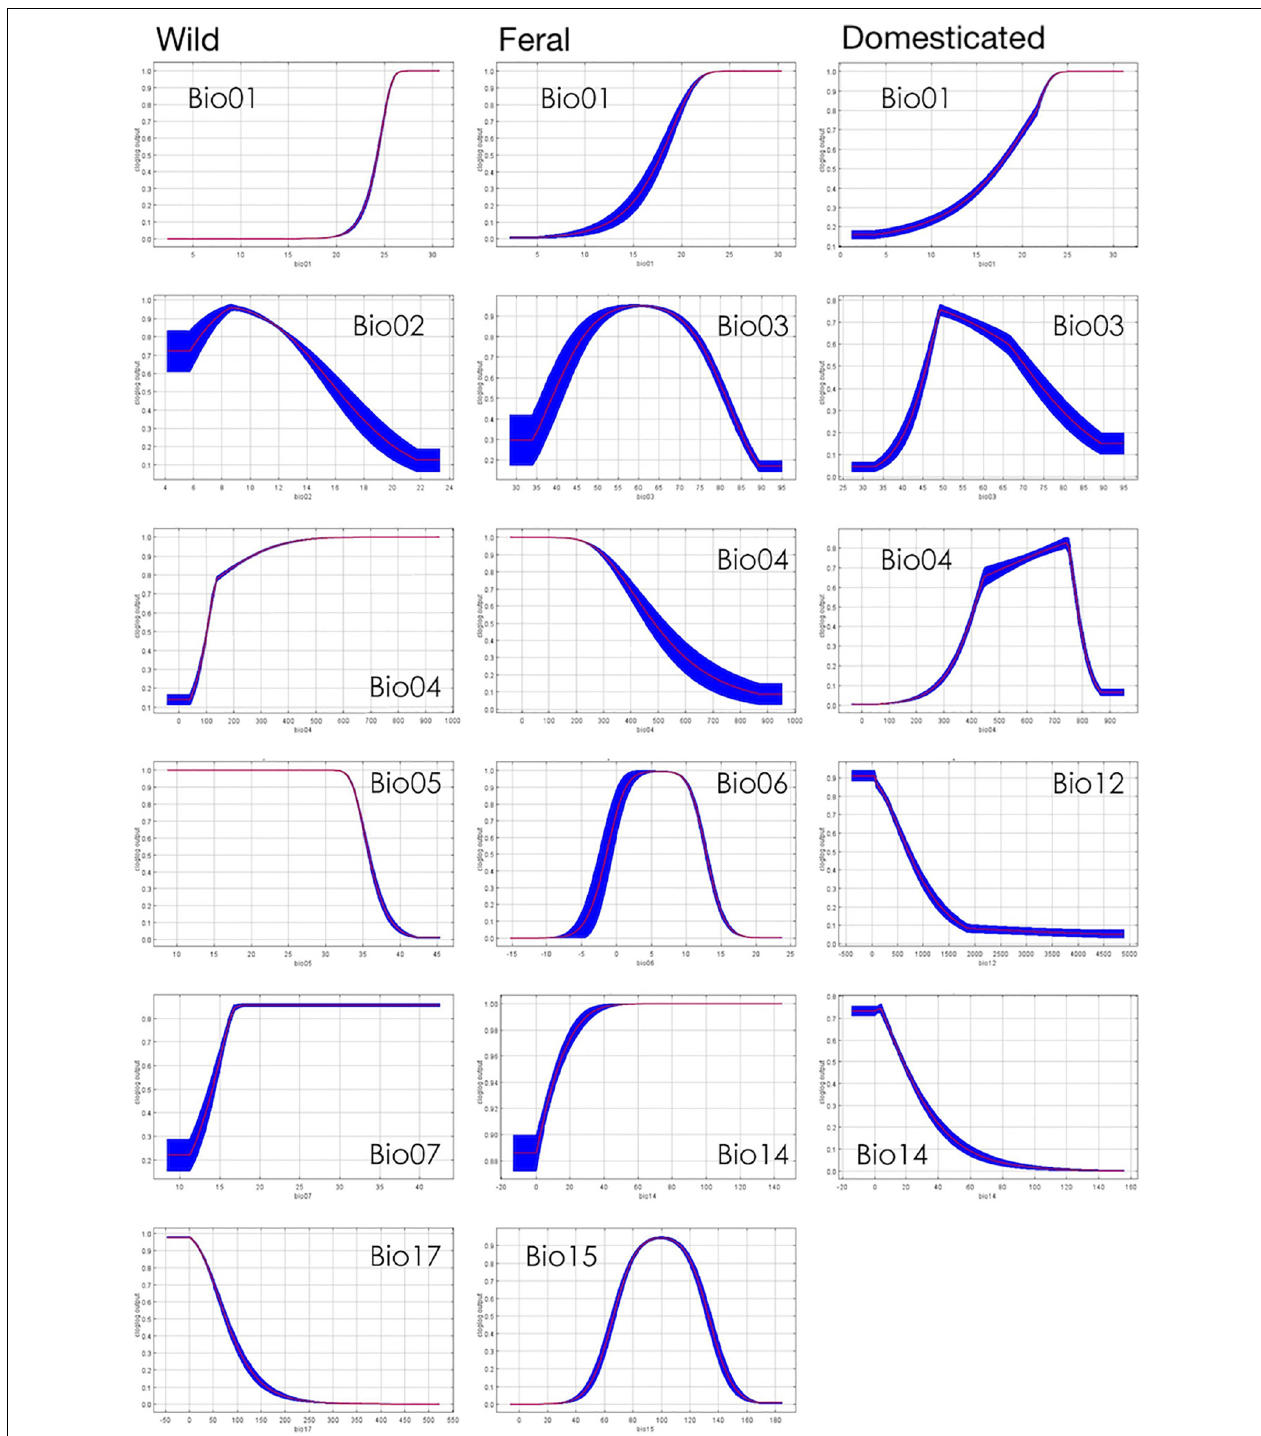
FIGURE 8 | Response curves showing the relationships between suitability and bioclimatic